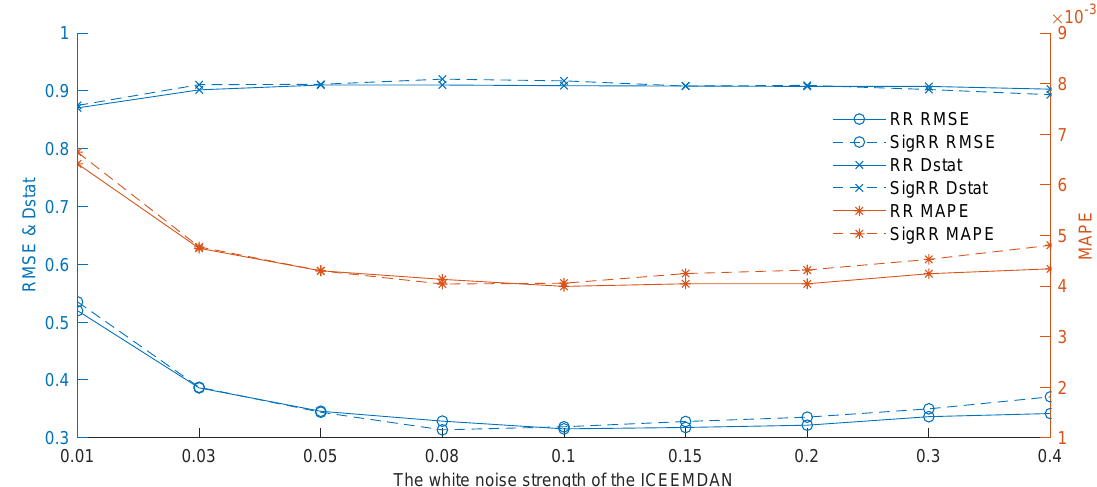
Figure 3. The impact of the white noise strength in the ICEEMDAN by RR and SigRR.